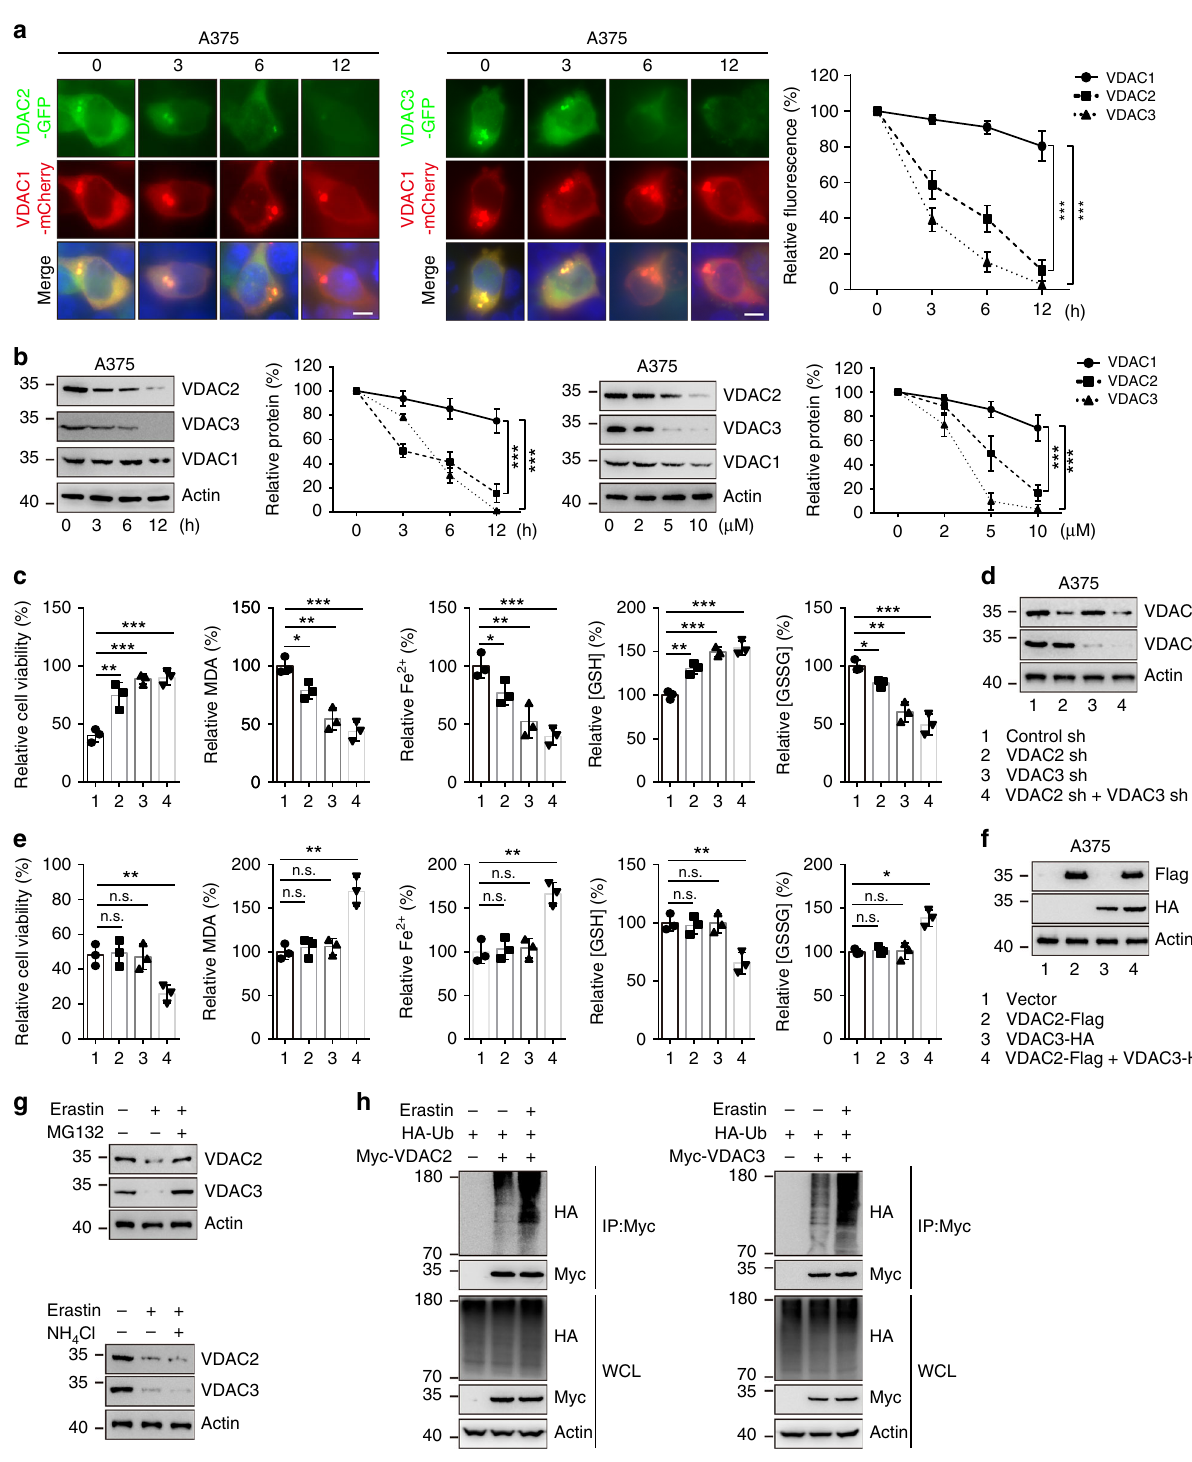
lacks ubiquitin ligase activity, did not affect the level of VDAC2/3, indicating that the E3 catalytic activity of Nedd4 was required for VDAC2/3 protein destabilization (Fig. 3a). Con- sistently, the half-life of VDAC2/3 was signi fi cantly reduced in Nedd4 overexpression cells (Supplementary Fig. 3a) but not in Nedd4 C867S overexpression cells (Supplementary Fig. 3b) as detected by cycloheximide chase assay. These results suggest that Nedd4 is the E3 ligase that destabilizes VDAC2/3 in mel- anoma